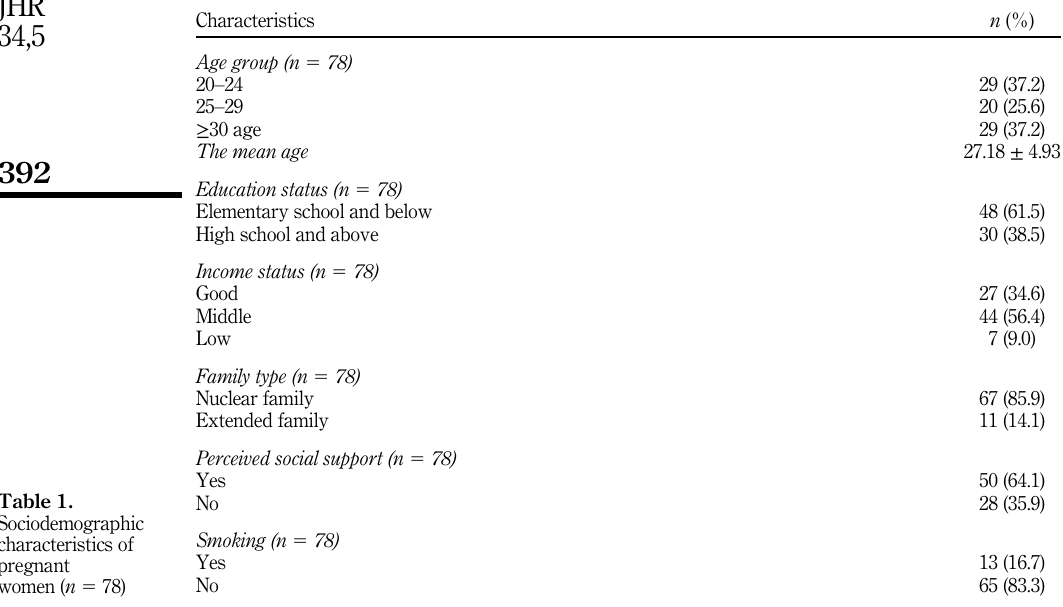
characteristics of